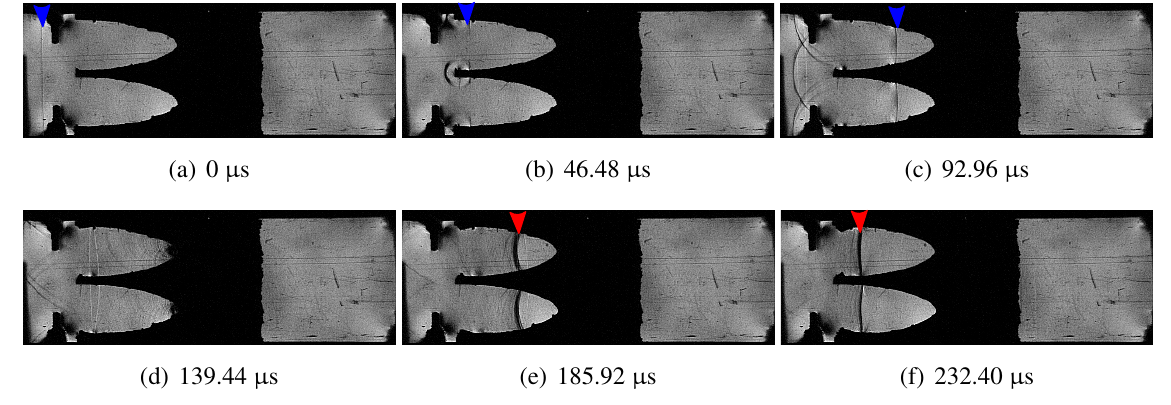
Figure 11. Open cell foam, Case 2C.